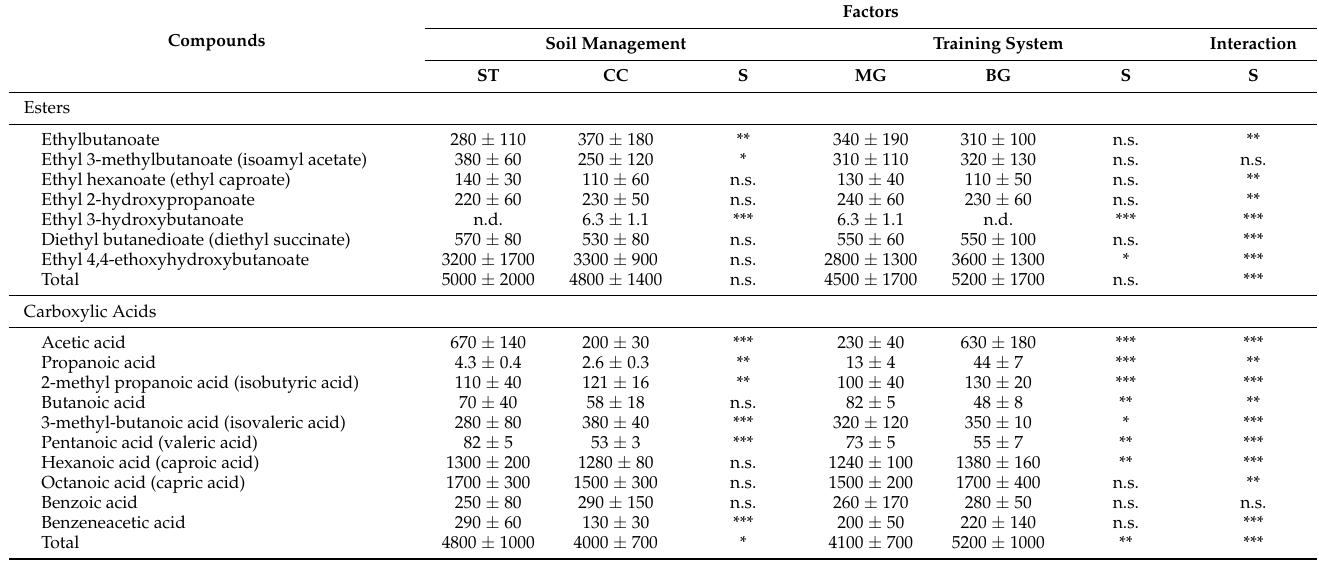
Table 4. Concentration ( µ g/L—means values and standard deviation) of single free volatile compounds identified in the Negroamaro wines from the two soil managements and training systems by SPE-GC-MS.